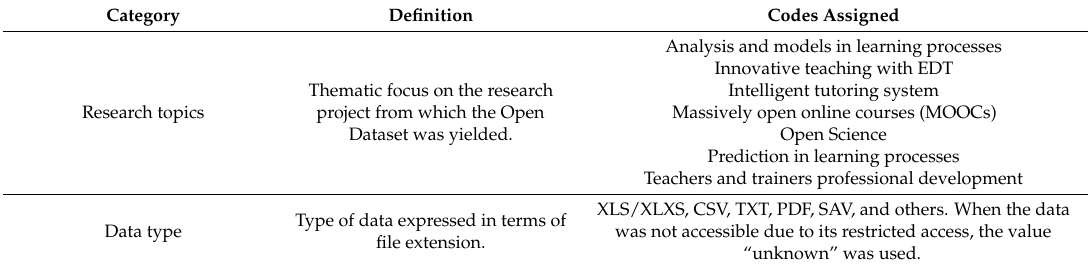
Table 1. Codebook with the labels and values used in the codification of